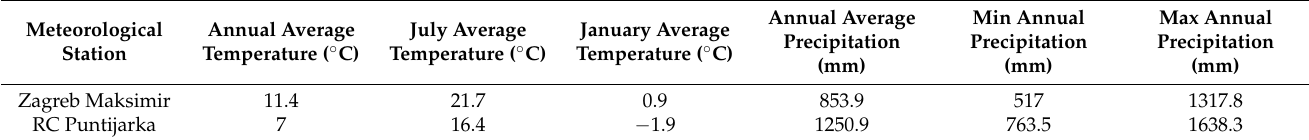
Table 1. Climatological data for Zagreb Maksimir and RC Puntijarka (1980–2015). Meteorological